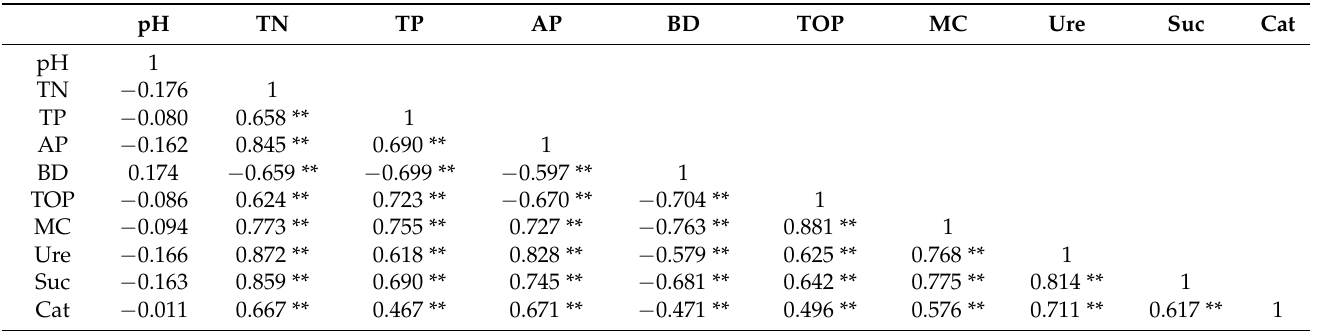
Table 6. Pearson correlation coefficients among soil properties.